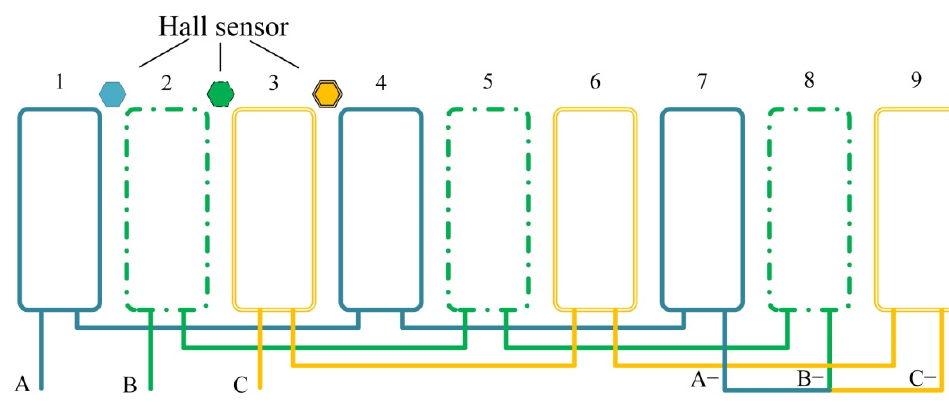
Figure 17. Coil winding mode.